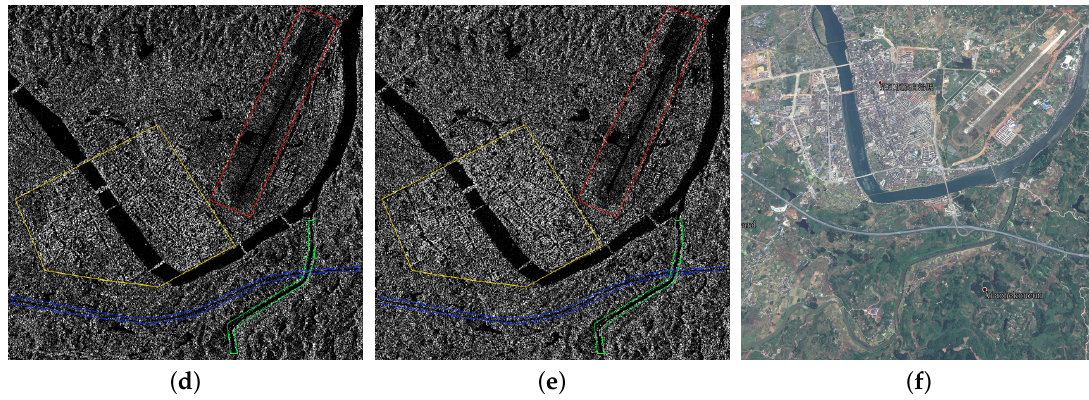
Figure 1. ( a ) HH; and ( b ) HV are dual polarization GF-3 images of Hunan province (3 July 2017) imaged in FSII mode with 10 m resolution covering 10,894.8 square kilometers. Image size is 10,996 × 9908 pixels. ( c ) The optical image of the same area obtained from Google Earth. ( d – f ) Selected areas of ( a – c ). City, airport, highway, and part of water are marked by yellow, red, blue and green frames,